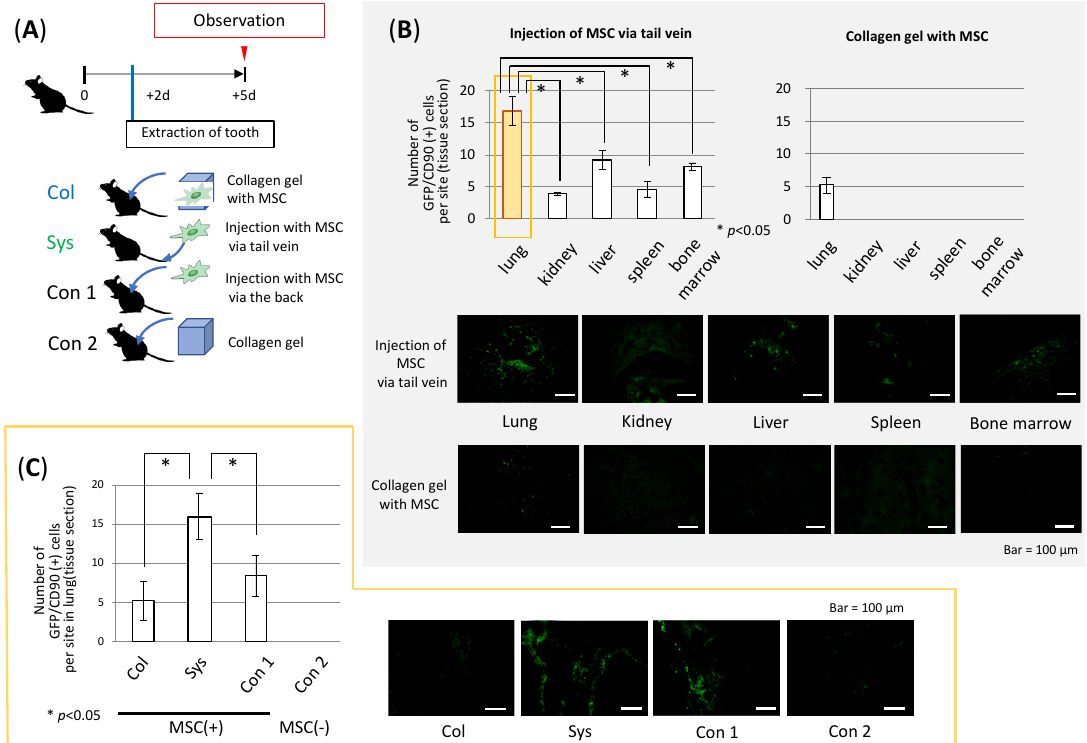
Figure 4. Accumulation of MSCs into organs following tooth extraction. ( A ) Experimental protocol for in vivo experiments. ( B ) Numbers of MSCs in several organs. At 5 days after systemic injection via the tail vein and injection of collagen gel with MSC, cell numbers in the lung, kidney, liver spleen, and bone marrow were counted and plotted. In particular, the lung accumulated a large number of MSCs. Scale bar, 100 µ m. ( C ) As novel and conventional methods, MSCs isolated from GFP-transgenic mice were cultured with or without a collagen gel and injected into mice 2 days before tooth extraction. At 5 days after MSC administration, the number of cells accumulated in the lung was evaluated. Systemic injection via the tail vein resulted in significantly higher numbers of MSCs in the lung than in the collagen group or in mice injected in the back with MSCs. Scale bar, 100 µ m. * p < 0.05.